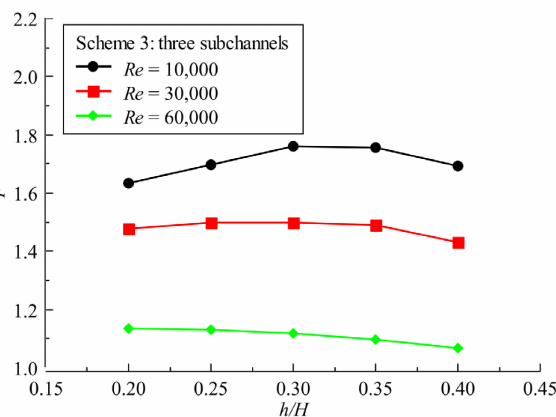
Figure 13. Effects of h/H on comprehensive thermal performance of X-shaped truss array channel of Scheme 3 at different Reynolds numbers.